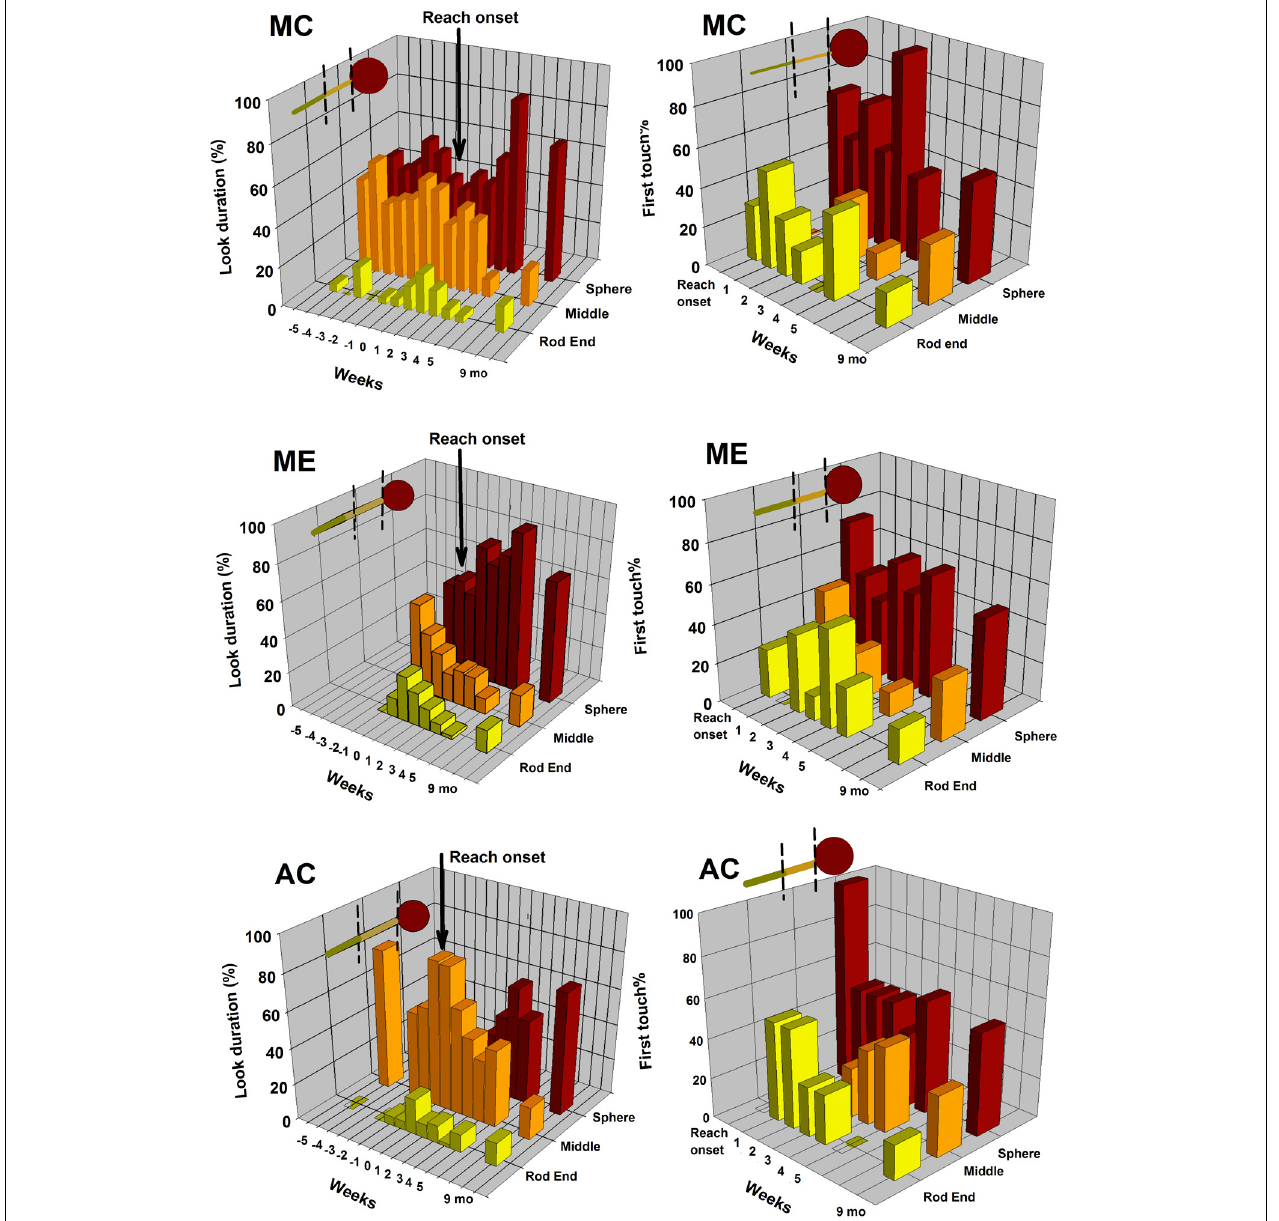
FIGURE 3 | Drumstick shaped object. The 3D bar graphs display the distributions of looking patterns on the object (graphs on the left) and distribution of first touched object area (graphs on the right) for each of the